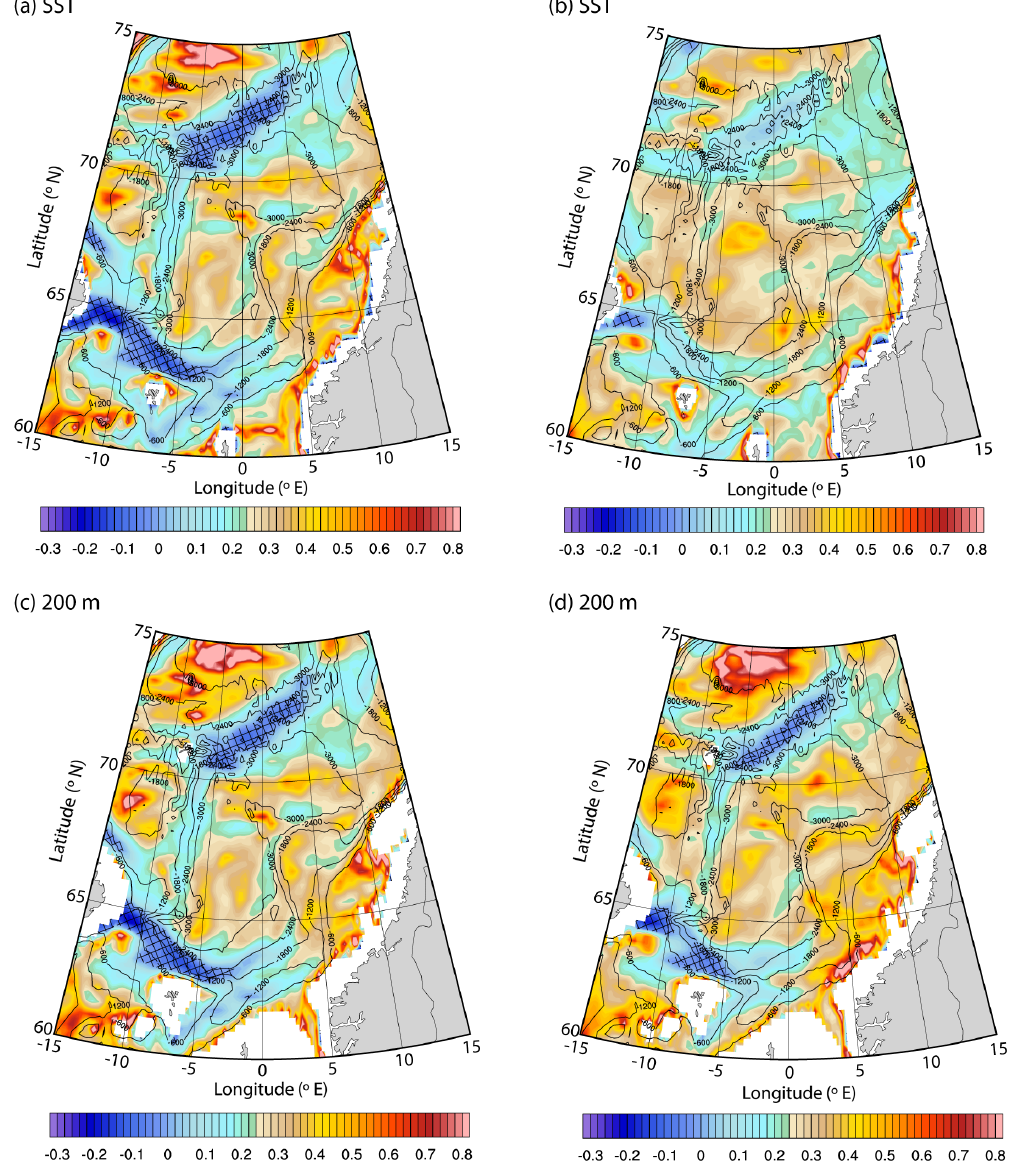
Figure 6. Singularity exponents estimated from TOPAZ (a–b) SST and (c–d) 200m potential temperature for (a, c) winter (DJF) and (b, d) summer (JJA) for the time period 1991–2015. Negative values are highlighted (black